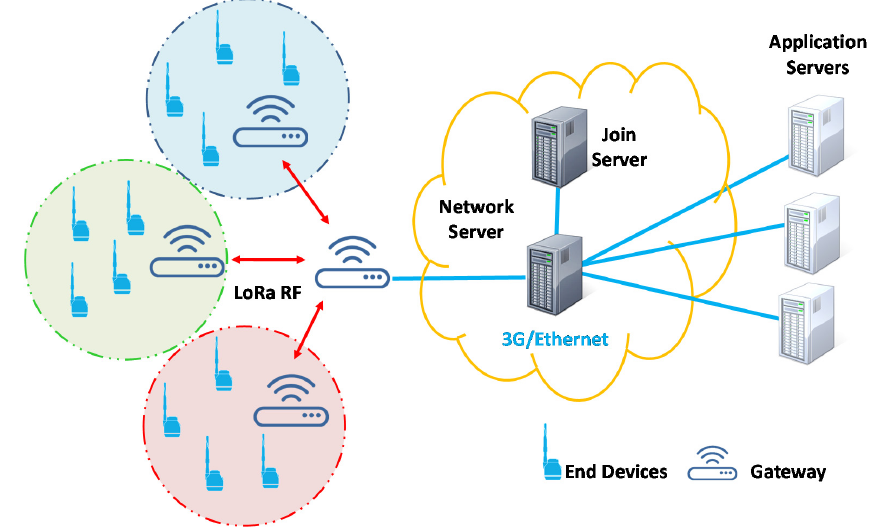
Figure 3. LoRaWAN network architecture.